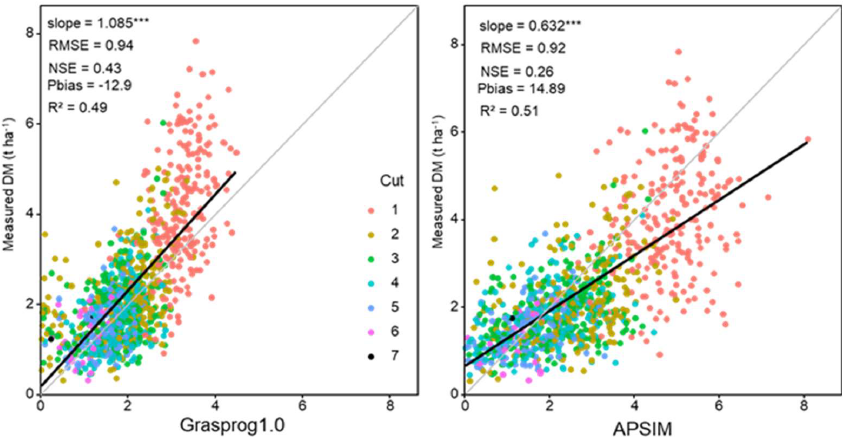
Figure 10. Measured grass dry matter (DM) vs. the predictions by GrasProg1.0 and APSIM for different cuts and years for the entire datasets from Germany and Denmark, with a total of 33 locations. *** indicates significance p < 0.001.